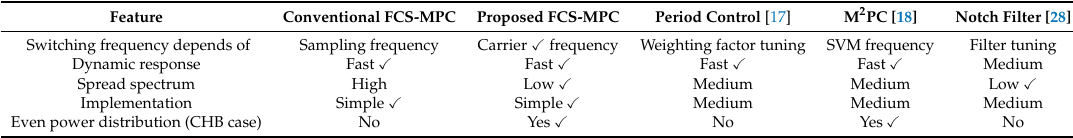
Table 5. Comparison among classical linear controller, proposed scheme and previous FCS